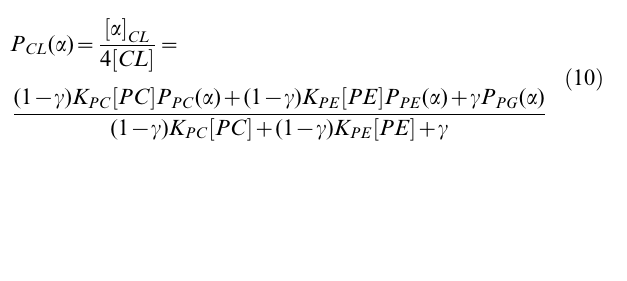
Table S1 PC, PE, PG, acyl CoA, and CL concentrations as measured by MDMS-SL. Table S2 Observed and model-predicted cardiolipin distribution for 14 samples and B6 tissues. Table S3 Inferred CL acyl compositions and experimen- tal compositions in acyl donors PG, PC sn -2, PE sn -2,